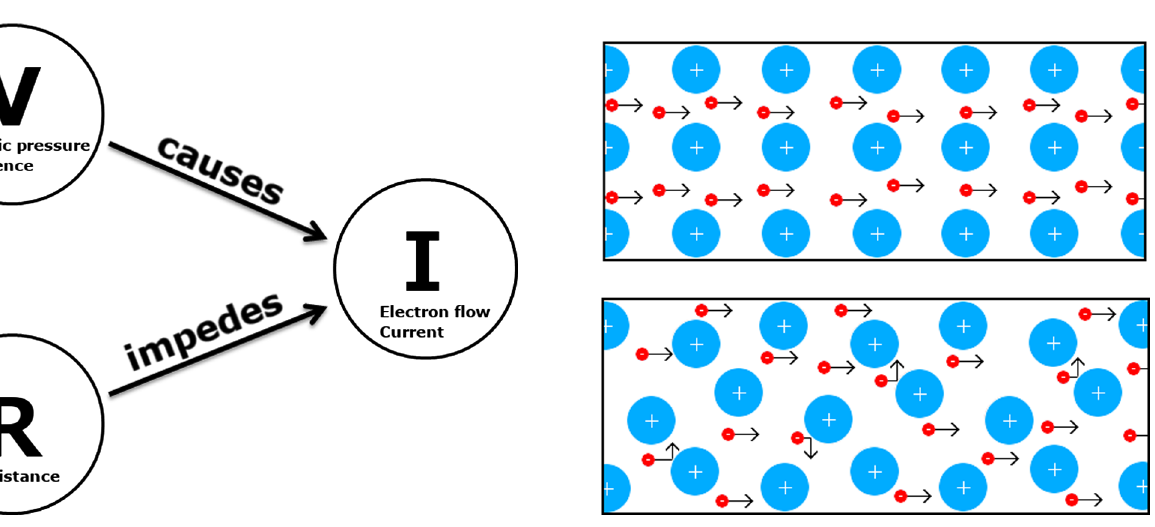
FIG. 7. A simple diagram visualizes the qualitative relationship between voltage ( V ), resistance ( R ), and current ( I ).